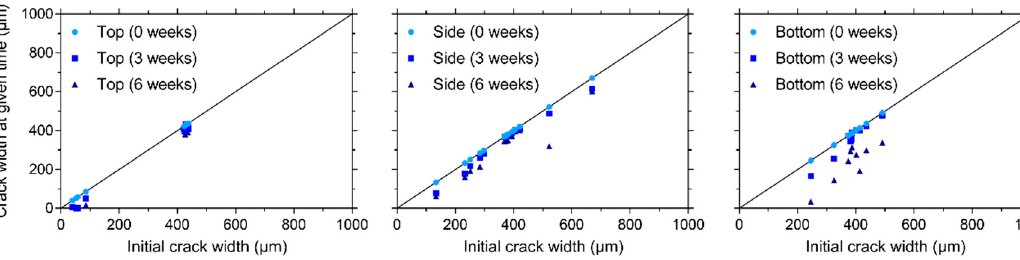
Figure 9. Evolution of the crack width under > 90% RH on the top, side, and bottom surfaces.